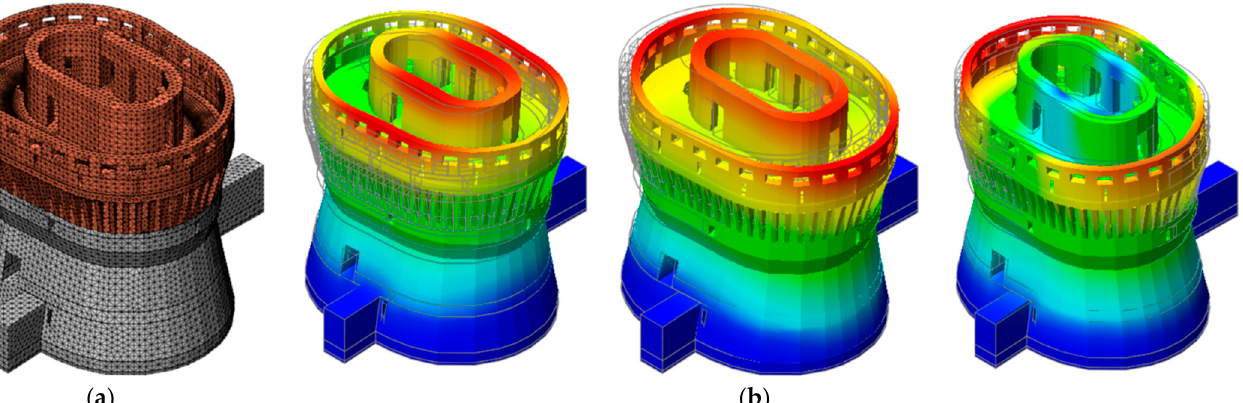
Figure 6. Starting numerical model discretization ( a ) and the corresponding first three modal shapes ( b ).